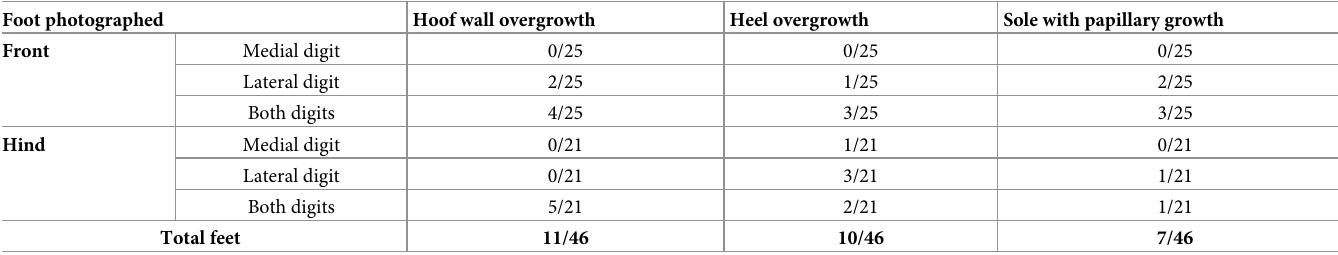
Table 5. Photographs of the solar surfaces demonstrated hoof overgrowth in both the front and hind feet of free-ranging giraffe. When sole overgrowth was observed, the underside of the foot remained concave but sometimes had small amounts of papillary growth. Foot